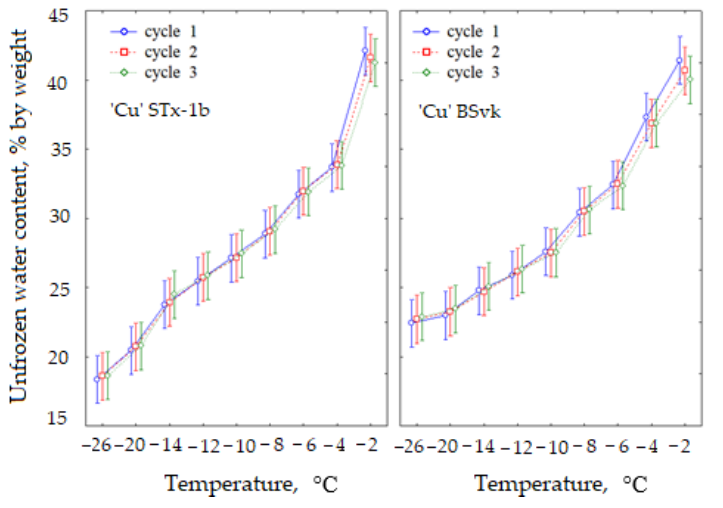
Figure 5. Mean unfrozen water contents at a given negative temperature for the individual F-T cy- cles, depending on the type of copper